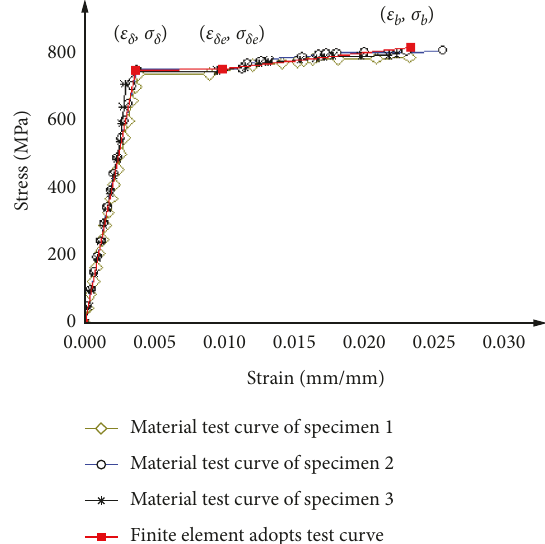
Figure 5: Nominal stress-strain curve of the material.